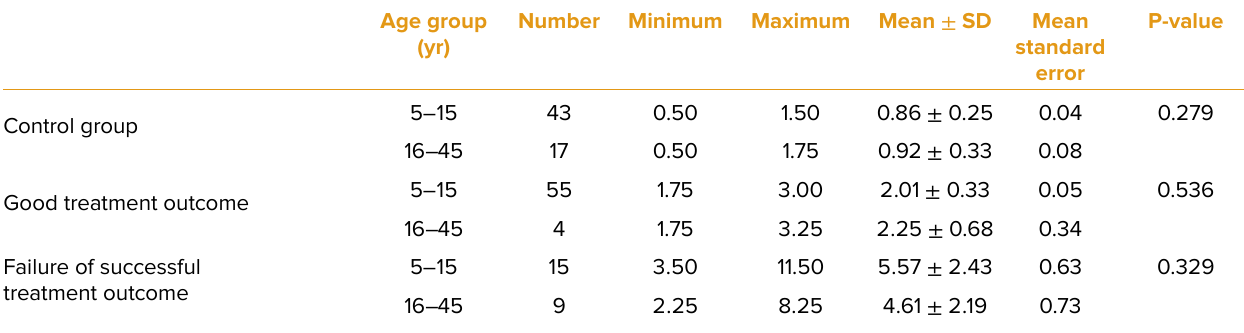
Table 2. Comparison of the mean anisometropia (diopter) among children and adult groups based on amblyopia treatment